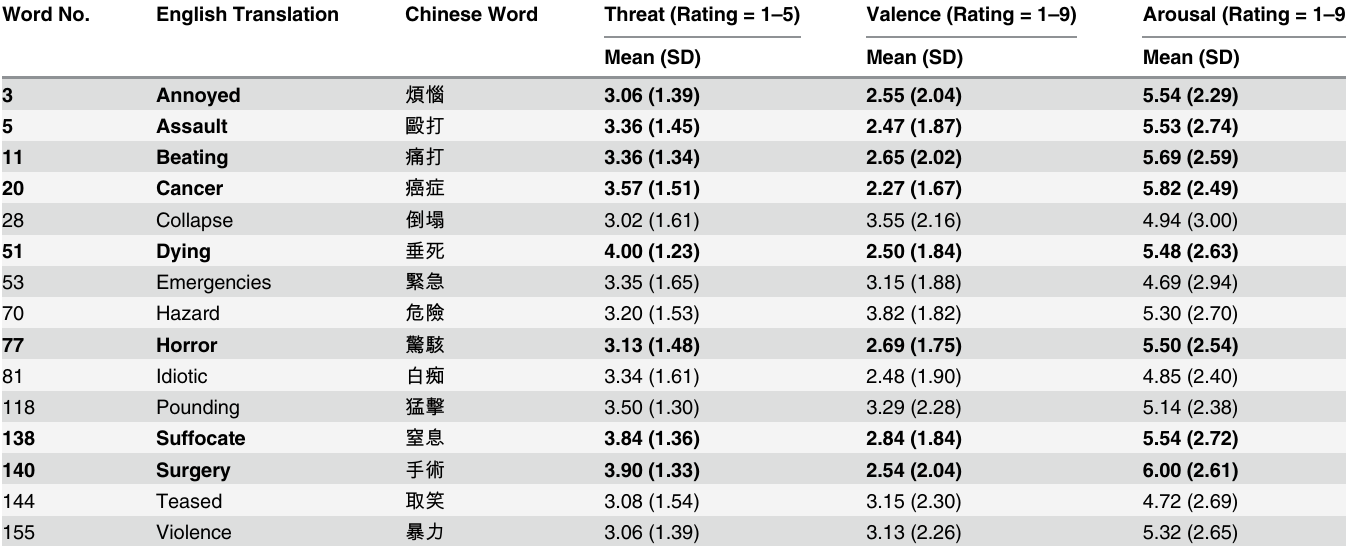
Table 3. Words with High Threat Rating. Word